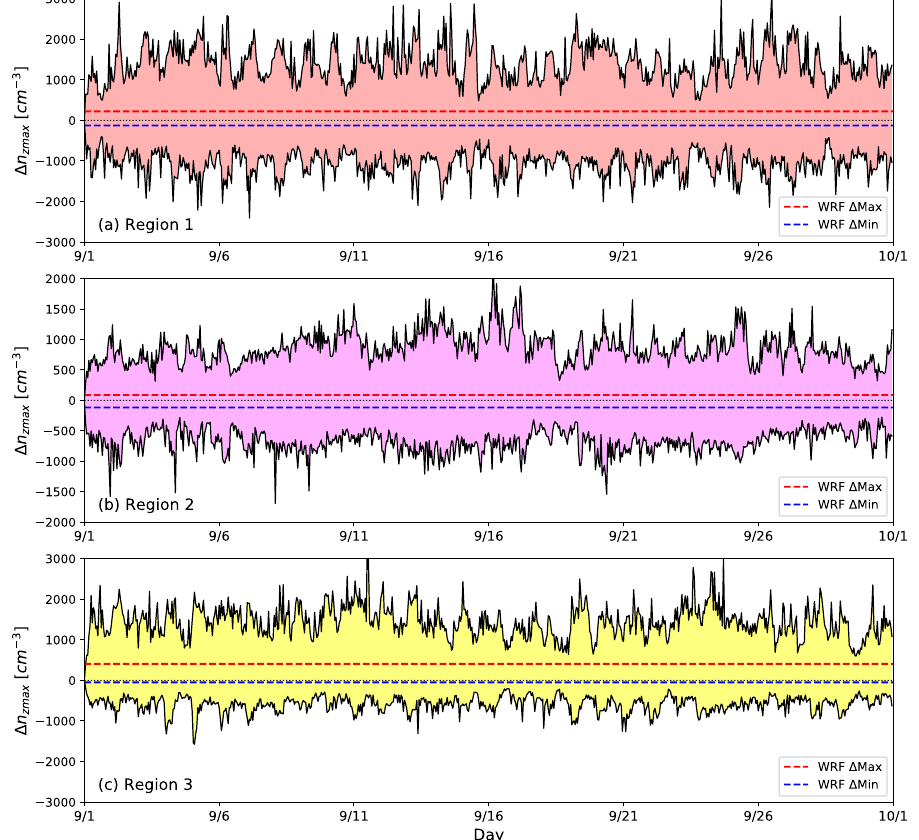
Figure 4. Temporal evolution of maximum and minimum (cid:31) n zmax shown by the shading, in ( a ) Region 1, ( b ) Region 2, and ( c ) Region 3. The maximum and minimum (cid:31) n zmax are shown in red and blue lines, respectively. Note that (cid:31) n zmax in this figure (shading) was based on columns where there was a cloud (i.e., q c ≥ 0.001 gm − 3 ) in both CHEM-FIRE and CHEM-NOFIRE at each plotted moment, whereas the (cid:31) n zmax values are the differences in the monthly mean values n zmax that were separately calculated for CHEM-FIRE and CHEM- NOFIRE regardless of the existence of clouds in the other run. Therefore, the average of (cid:31) n zmax (the upper and lower ends of the shading) in this figure may not exactly correspond to the red and blue lines.